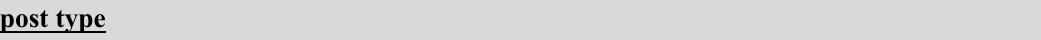
Table 1: Categories of compost types and classes Compost